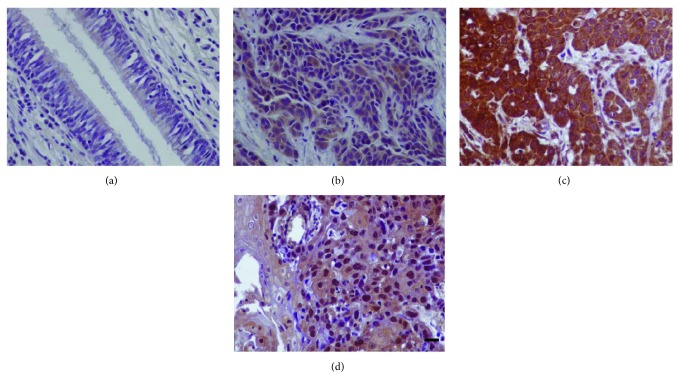
N-WASP immunohistochemical expression in human laryngeal carcinoma. (a) Negative N-WASP expression in the adjacent nonneoplastic epithelium. (b) A case of laryngeal carcinoma with low N-WASP expression. (c) Representative case of laryngeal carcinoma with high cytoplasmic N-WASP expression. (d) Nuclear expression of N-WASP in a case of laryngeal carcinoma. Bar corresponds to 50 μm (×400).